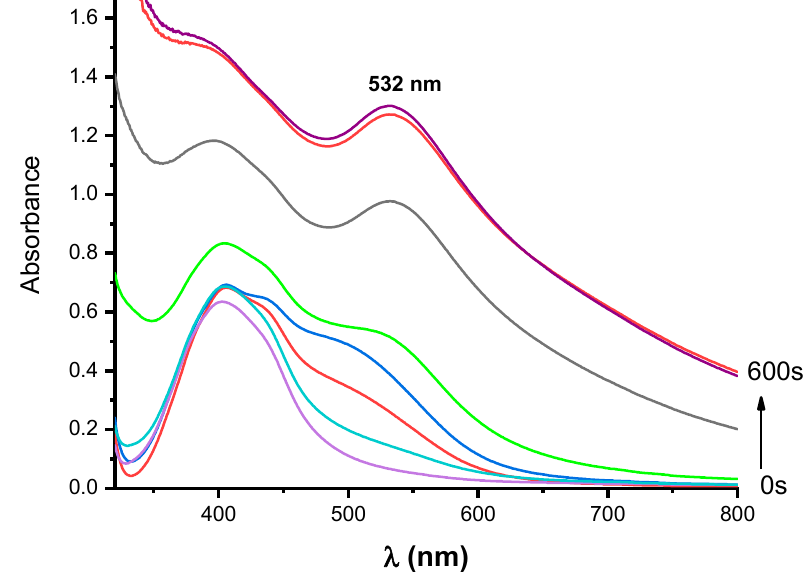
Figure 6. Time evolution of the absorption spectrum of the ethylene glycol diacrylate (EGDA) during photopolymerization, irradiated mixtures ( λ irr = 419 nm). Solution: HLCuCl 0.05 wt% gold chloride 4wt%, TEA 1wt%, and iodonium salt 1 wt% dissolved in 93.95 wt%.